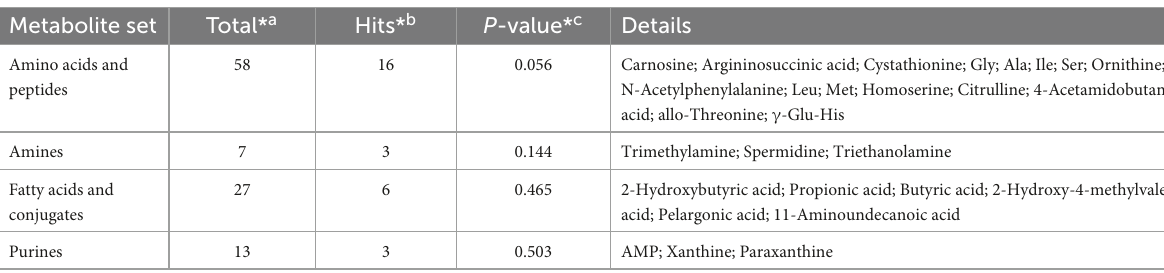
TABLE 4 Enrichment analysis based on chemical